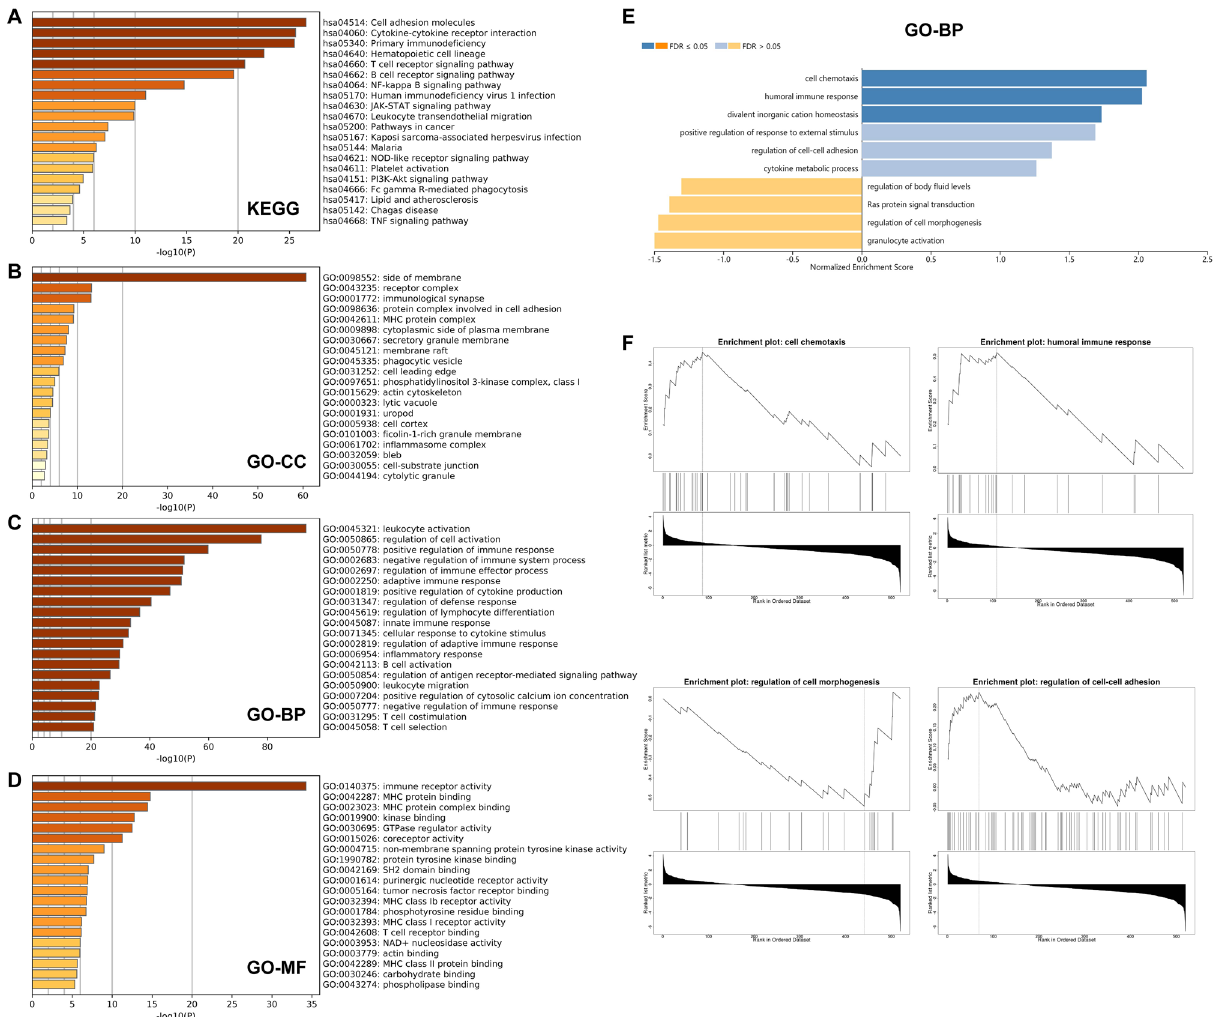
Figure 5. Enrichment analysis of NLRC3 in LUAD using the Metascape or WebGestalt database. ( A – D ) Kyoto Encyclopedia of Genes and Genomes and Gene Ontology pathways of the 696 genes most positively associated with NLRC3 . ( E , F ) Gene set enrichment analysis results for NLRC3